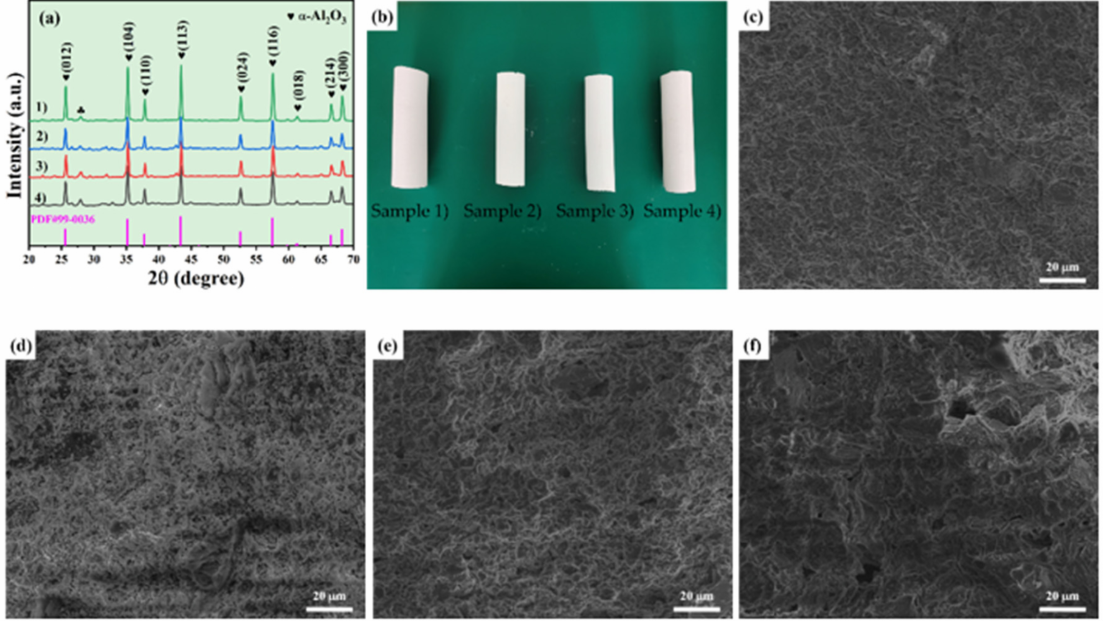
Figure 4. ( a ) The XRD patterns of Al 2 O 3 -based PCMT sintered at 1150 ◦ C using alumina powders with different grit designations: (1) 1500#, (2) 300~325#, (3) 150~250#, and (4) 80~150#; ( b ) the digital photography of single-channel porous alumina ceramic membrane tubes (sample 1–4); ( c – f ) the surface SEM images of porous alumina ceramic membrane tubes with different grit designations at 1200 ◦ C: ( c ) 1500#; Sample 1; ( d ) 300~325#, Sample 2; ( e ) 150~250#, Sample 3; and (f ) 80~150#, Sample